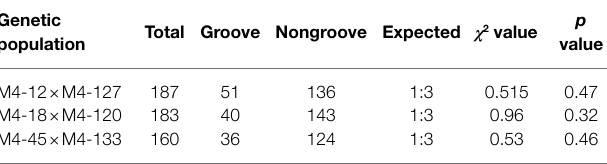
TABLE 1 | Primers in this research. Control gene primer